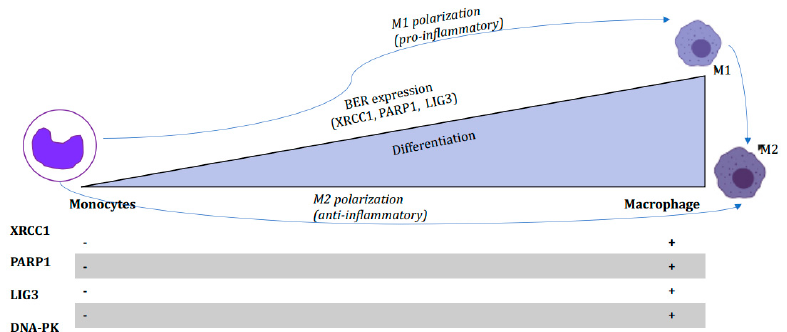
Figure 1. Base excision repair capacity in macrophage. Monocytes are key players in the immune system and contribute as a source for dendritic cells and macrophages. Monocytes differentiate into M1 and M2 macrophages. DNA repair capacity restored in M1 and M2 macrophage. Monocytes are deficient in main base excision repair genes, including POLB, XRCC1, and ligase III and non- homologous end joining repair genes, including DNA-PK.